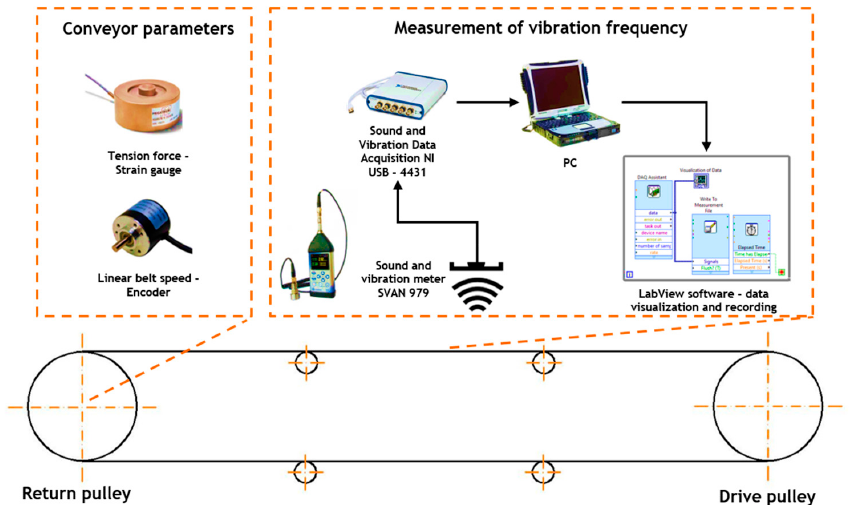
Figure 2. Diagram of the measurement systems—the system for measuring the basic operating parameters of the conveyor (on the left), and the system for measuring transverse vibration frequency in the belt (on the right).